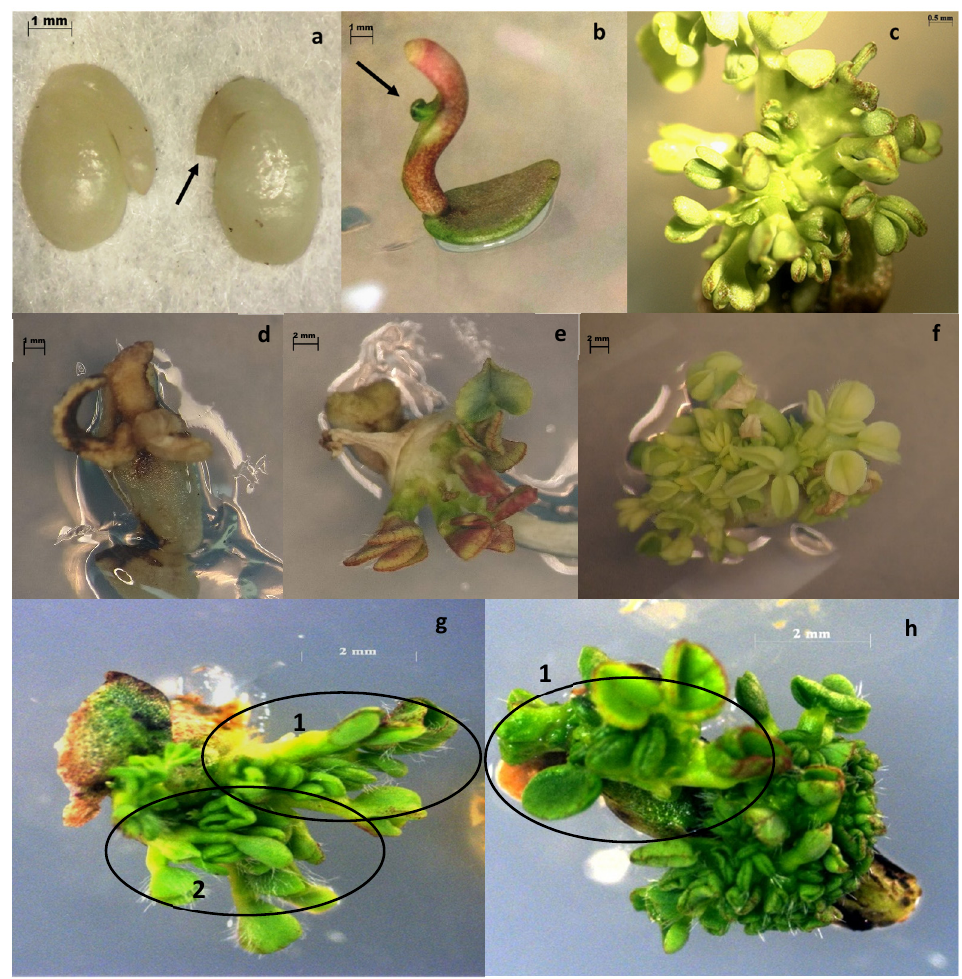
Figure 3. Seed cut procedure and regeneration: ( a ) seed cut with 1–2 mm segment of cotyledonary petiole attached (arrow showing cut), Scale = 1 mm; ( b ) shoot inducing in RM73 medium after 1 week (arrow showing shooting starting point), Scale = 1 mm; ( c ) multiple shoot generation through direct organogenesis after two weeks of culture. Dead explants identified at three stages; Scale = 0.5 mm; ( d ) Shoot apical meristem tissue was regenerated after 3 days in RM73 medium, but after two days in kanamycin 100 mg L − 1 , all explant tissue died; Scale = 1 mm; ( e ) Explant dying after 15 days of culture. The browning started at the top of the explant shoot; Scale = 2 mm; ( f ) Explant dying after 30 days of culture. The whole explant shows general tissue damage (yellowing); it was confirmed as dead one week after this photograph was taken; Scale = 2 mm; ( g ) Explant shoots were regenerated from the original apical meristem tissue. Two independent shoots can be distinguished; Scale = 2 mm ( h ) One shoot is clearly developed, whereas other plant tissue remains less differentiated; Scale = 2 mm. Images ( a – e ) were captured using microscope STEMI 2000-C (Carl Zeiss ® , Oberkochen, Germany). Images g and h were captured with AxioCam Color MRm (Carl Zeiss ® , Germany), software AxioVision V.4.5.